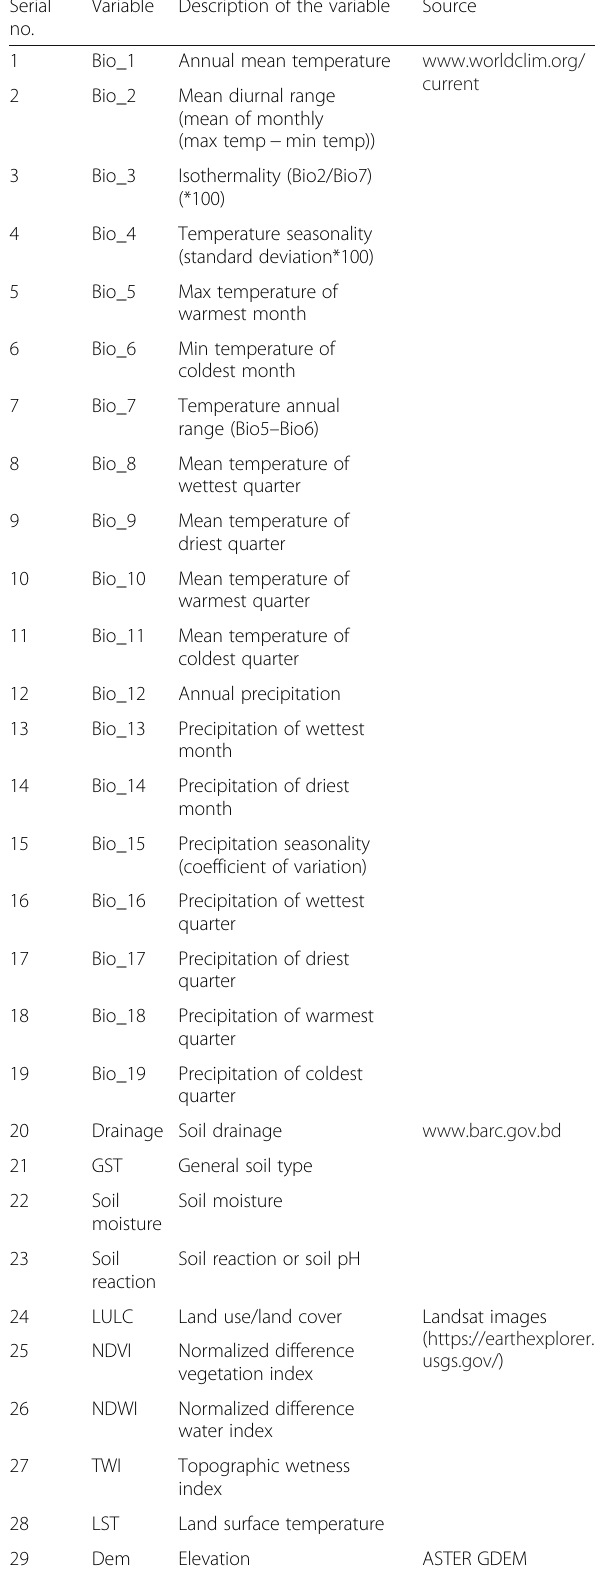
Table 1 Environmental variables used in this study Serial